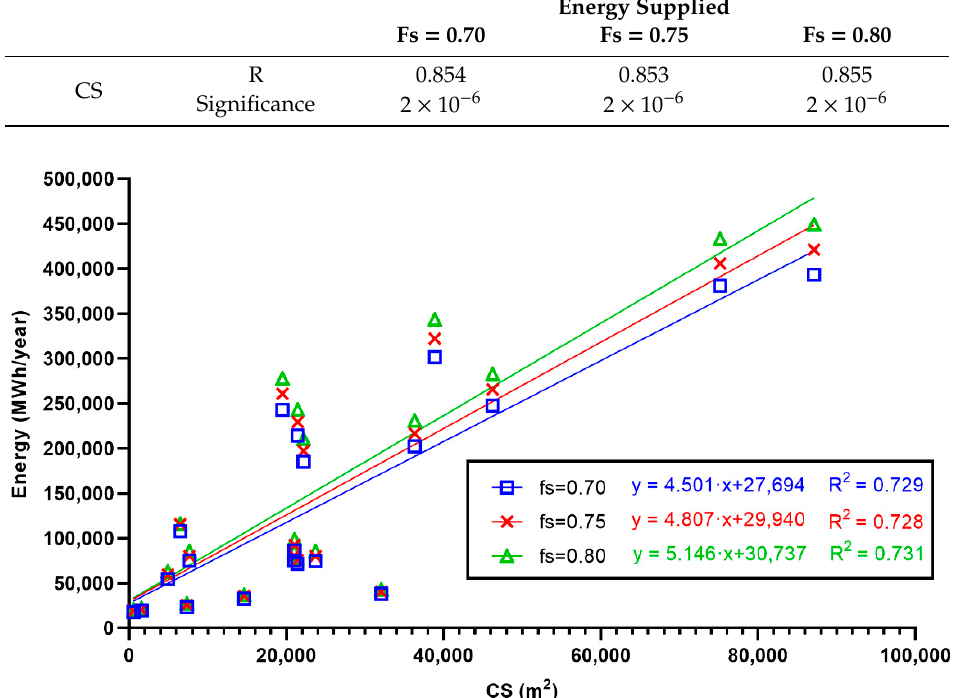
( b ) Figure 7. Graphs to verifying both normality and independence of residues: ( a ) histogram of the standardized residual and ( b ) scatterplot of the standardized residuals with the standardized predicted values. Therefore, the proposed linear regression model was adequate to predict the value of savings (or energy contributed by the facility) as a function of the built surface area of a hospital. The key performance indicator (KPI) shown in Equation (5) was constructed to help adjust the plant equipment at start-up: KPI #1 = Supplied Energy/CS.